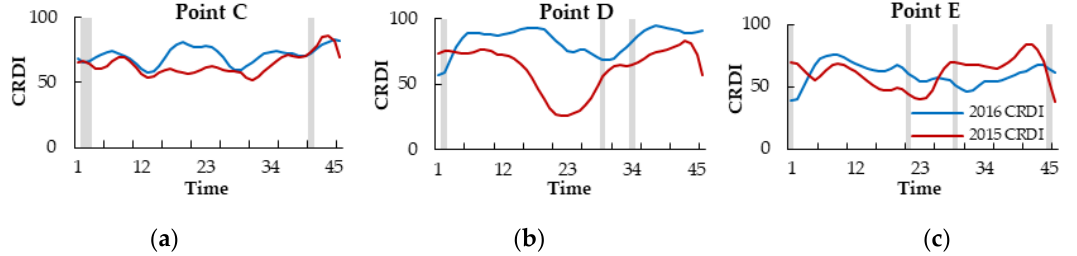
Figure 10. Comparison of current and same period of CRDI of point C ( a ), point D ( b ) and point E ( c ). The grey parts refer to the missing data of the original VCI. The blue line refers to CRDI of 2016, and the red line refers to CRDI of 2015.